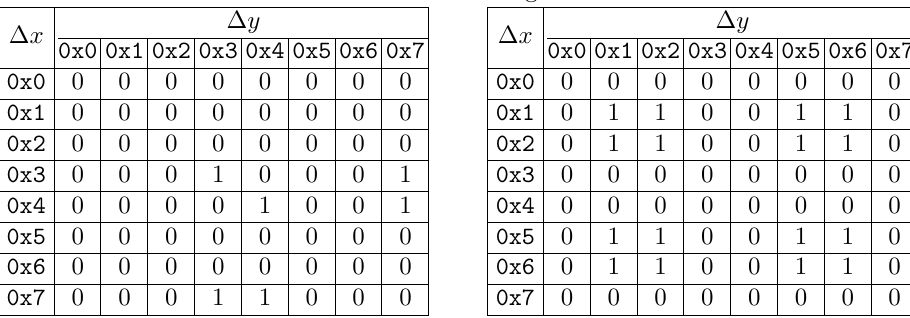
Table 5: Left table : 2 − 1 -DDT. Right table : 2 − 2 -DDT. ∆